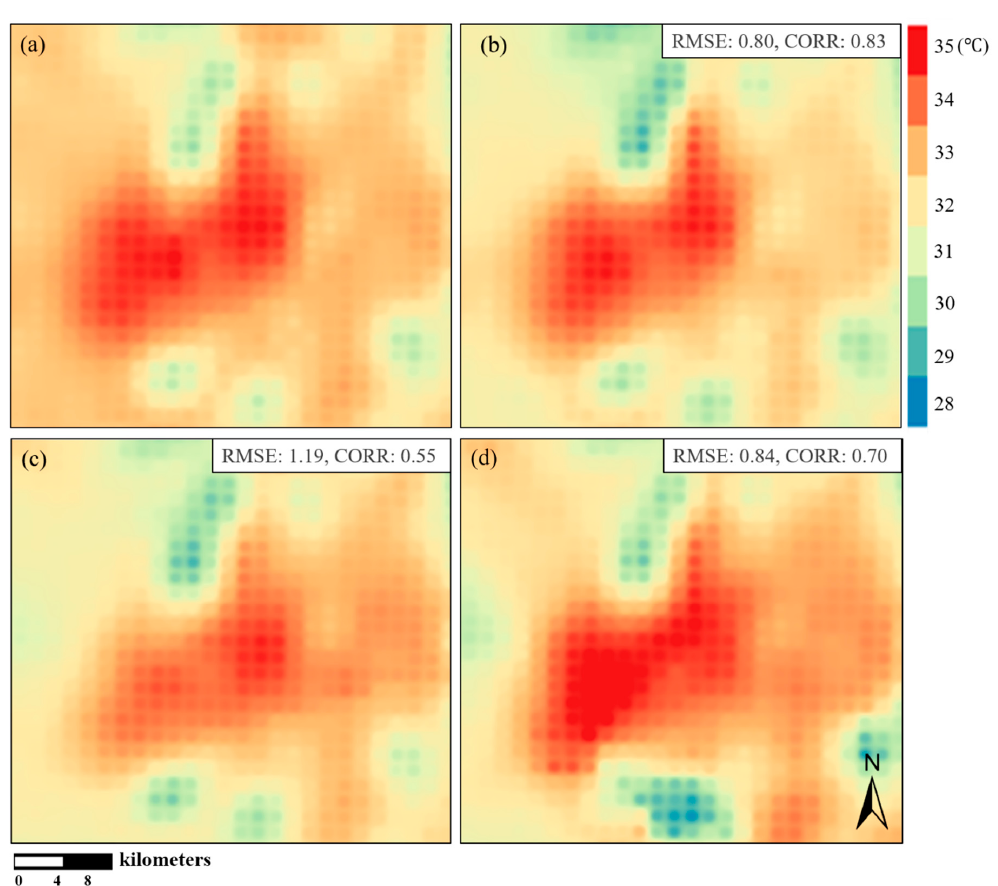
Figure 7. 1.5-m temperature distribution from LDAPS across South Korea, including the study region: ( a ) The forecast day (4 August 2017, 06:00 Coordinated Universal Time (UTC)); (b ) first analog day (4 August 2017, 05:00 UTC); ( c ) second analog day (10 August 2016, 06:00 UTC); and ( d ) third analog day (18 August 2016, 04:00 UTC). CORR = correlation coefficient.